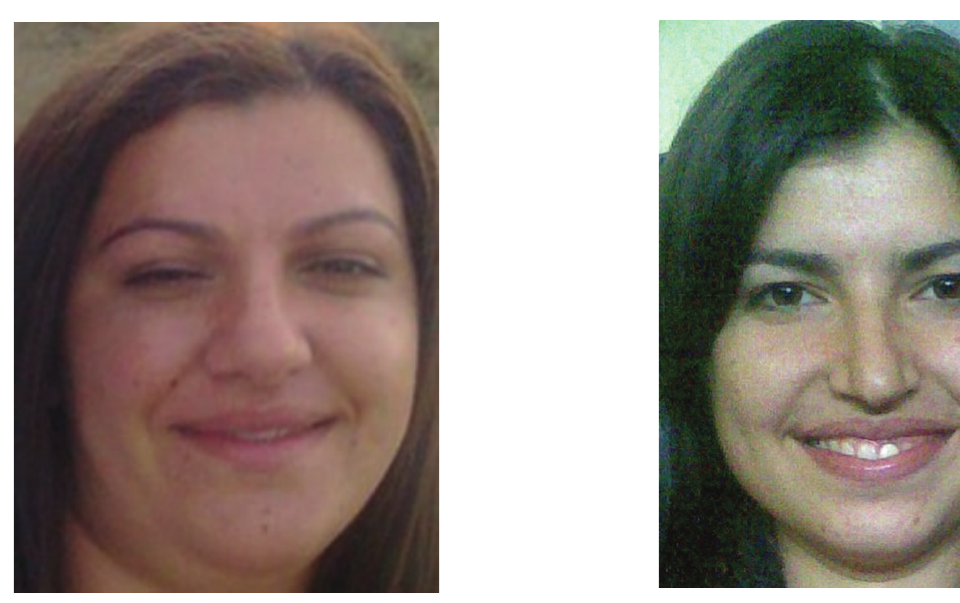
Figure 1: Case 1. Patient’s face. Figure 2: Case 2. Patient’s